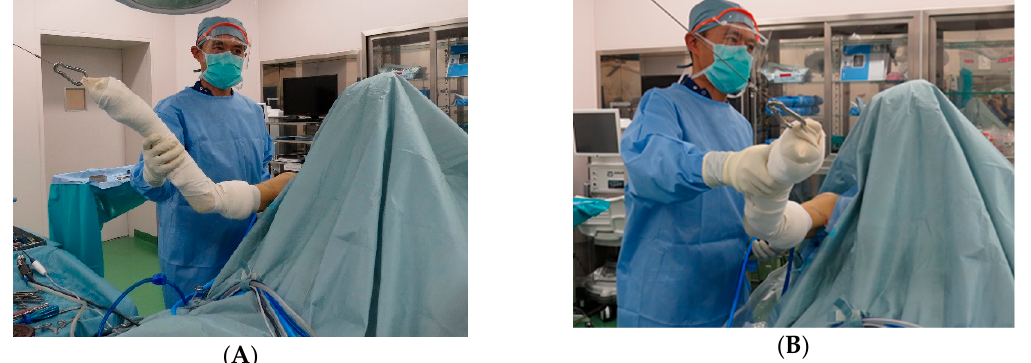
Figure 4. Manipulation methods for identification of the floating subscapularis. Flexion-external rotation ( A ) and flexion-internal rotation ( B ) of the shoulder shows unsynchronized movement of the subscapularis and gap between the subscapularis tendon and the lesser tuberosity.